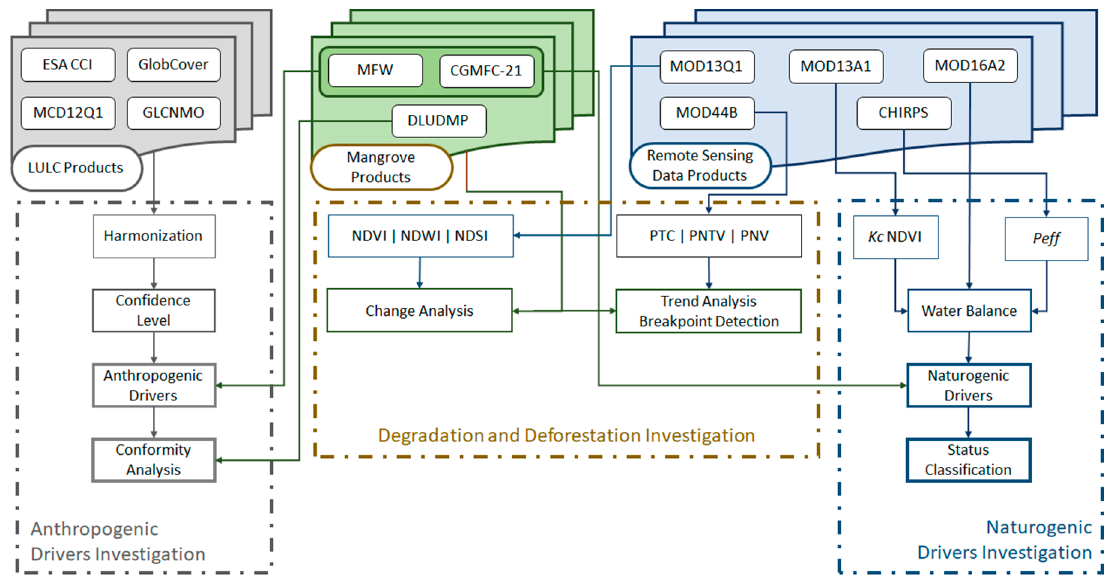
Figure 1. Research framework in this study.